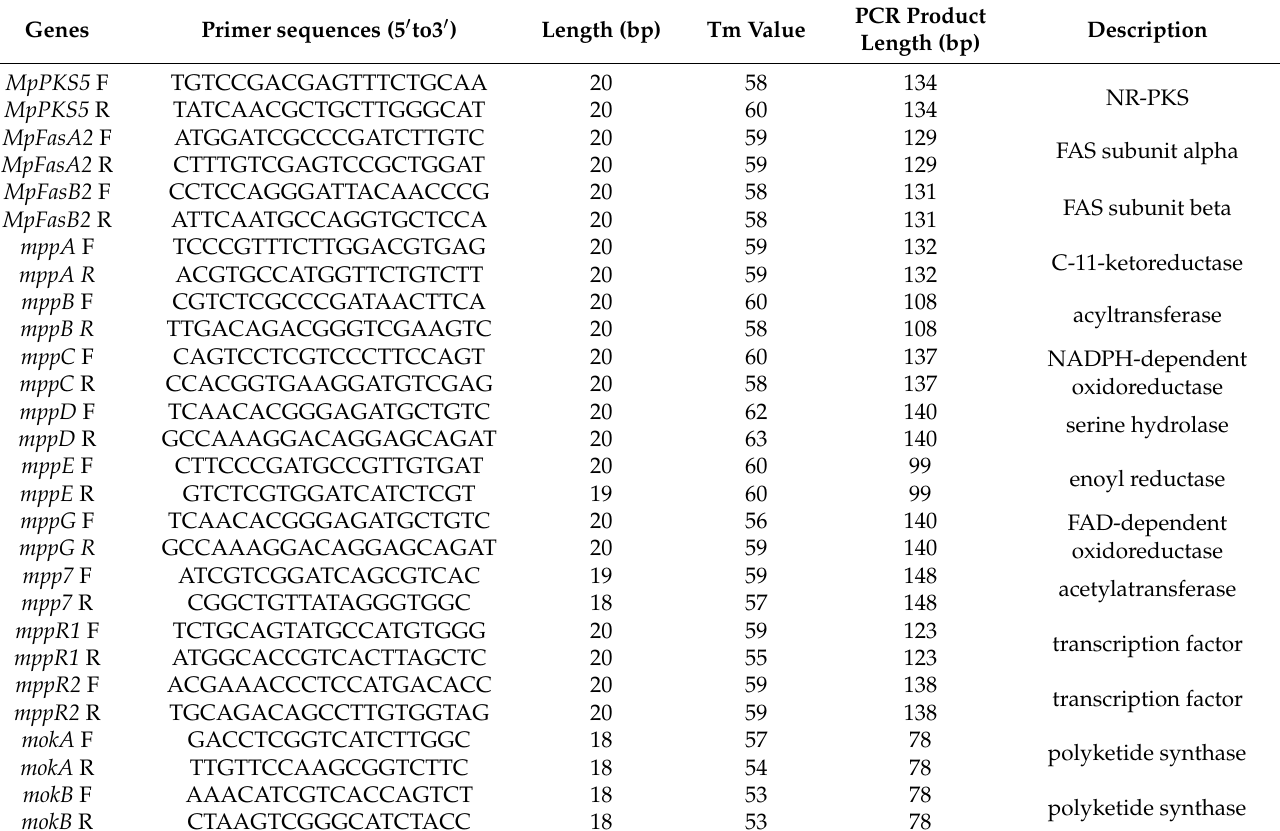
Table 1. Primer sequences for the key genes in M. purpureus